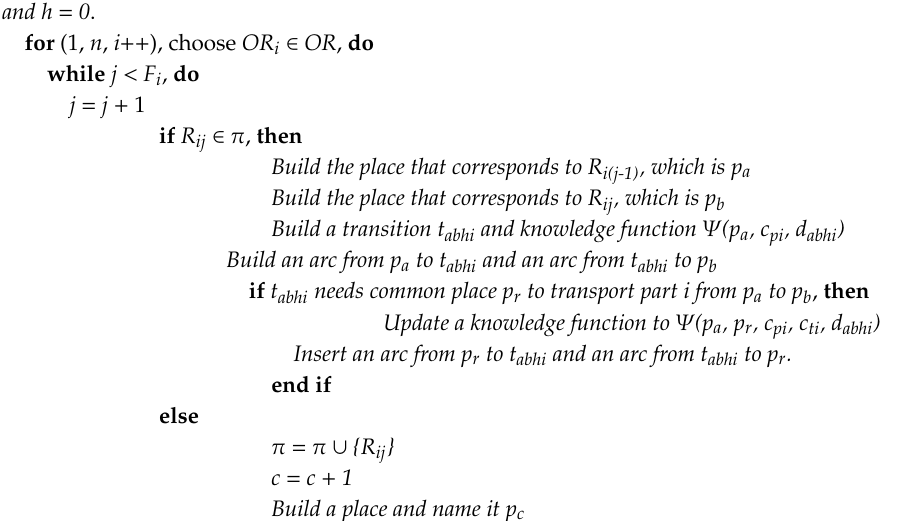
Algorithm 1: Modeling operation and transportation